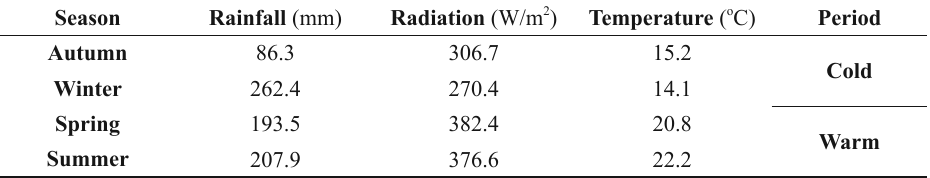
Climatic parameter averages: rainfall, radiation, average temperature and classi fi cation of cold and warm